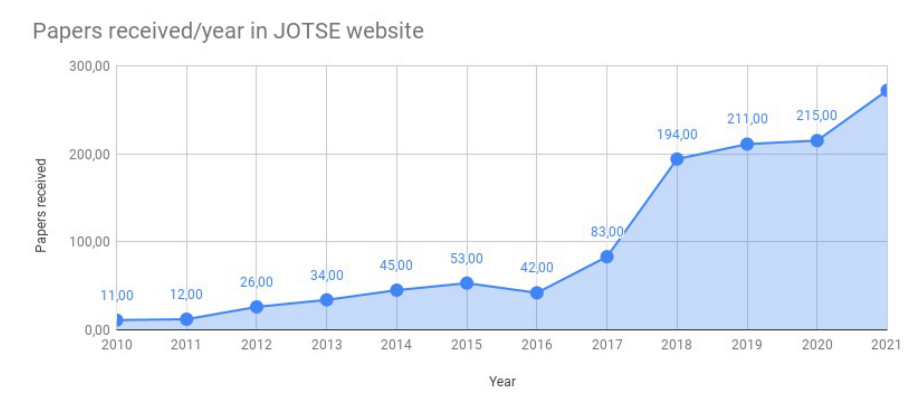
Figure 1. JOTSE's evolution